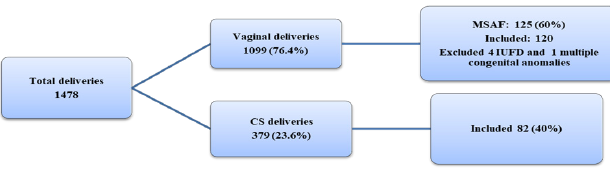
Fig. 1. Total deliveries and case